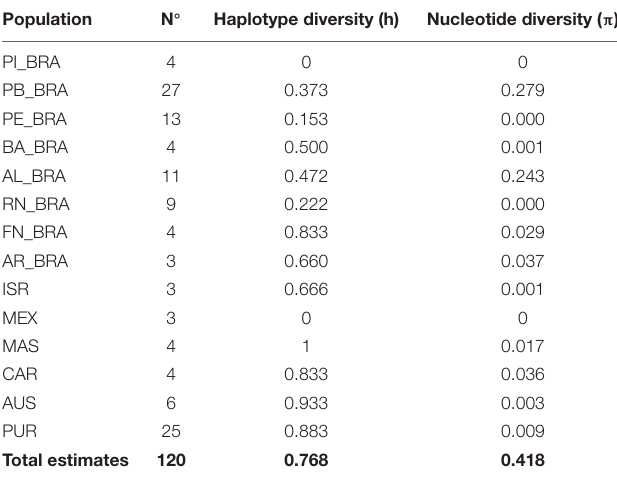
TABLE 1 | Estimates of genetic diversity in the 14 evaluated populations of Eretmochelys imbricata . Population N ◦ Haplotype diversity (h) Nucleotide diversity ( π